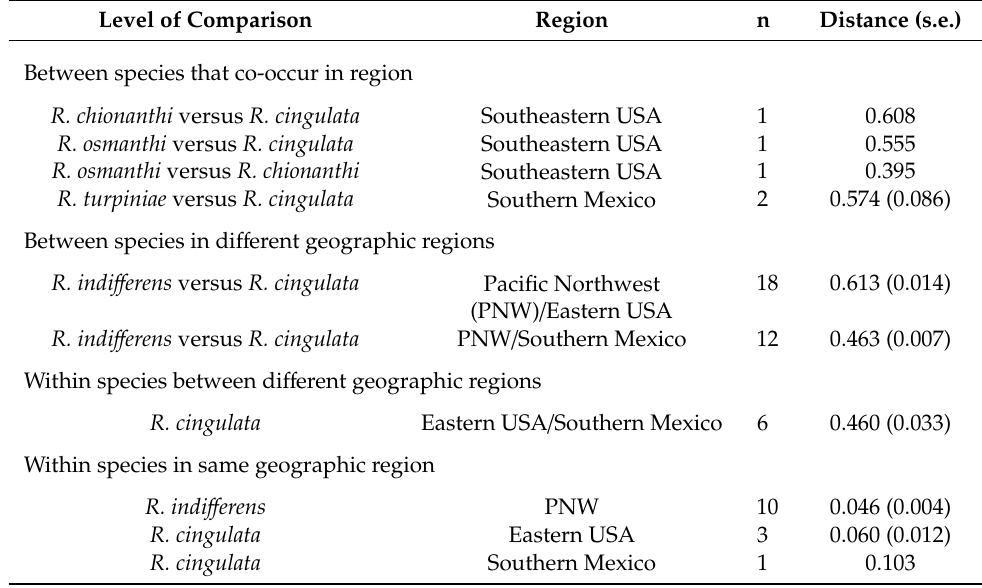
R. cingulata group flies that best fit the data was K = 13 (Figure 3A; Table S2). Rhagoletis indi ff erens comprised two diverged demes, central WA (site 5) and the remainder of the PNW (sites 1–4 and 6). The six subpopulations within R. cingulata included Arizona, USA (site 7); Texas, USA (site 8);